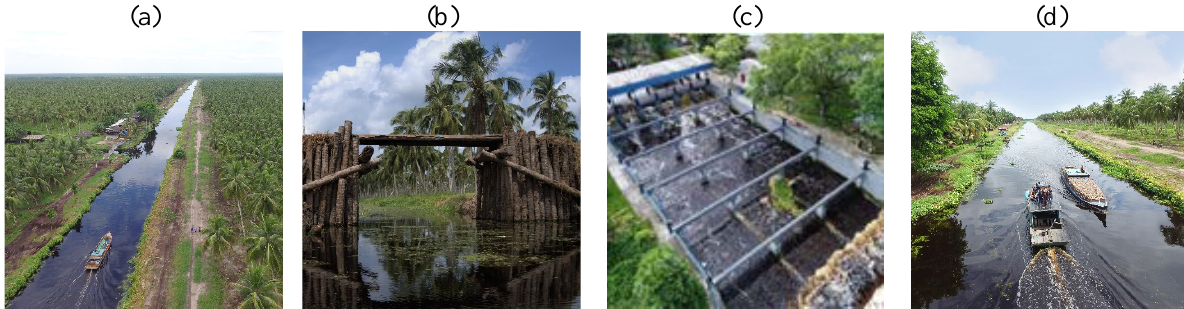
Figure 2. The three components of the water management system: (a) canal, (b) dike, (c) water gate, where (d) the canals are used as the main transportation system in the